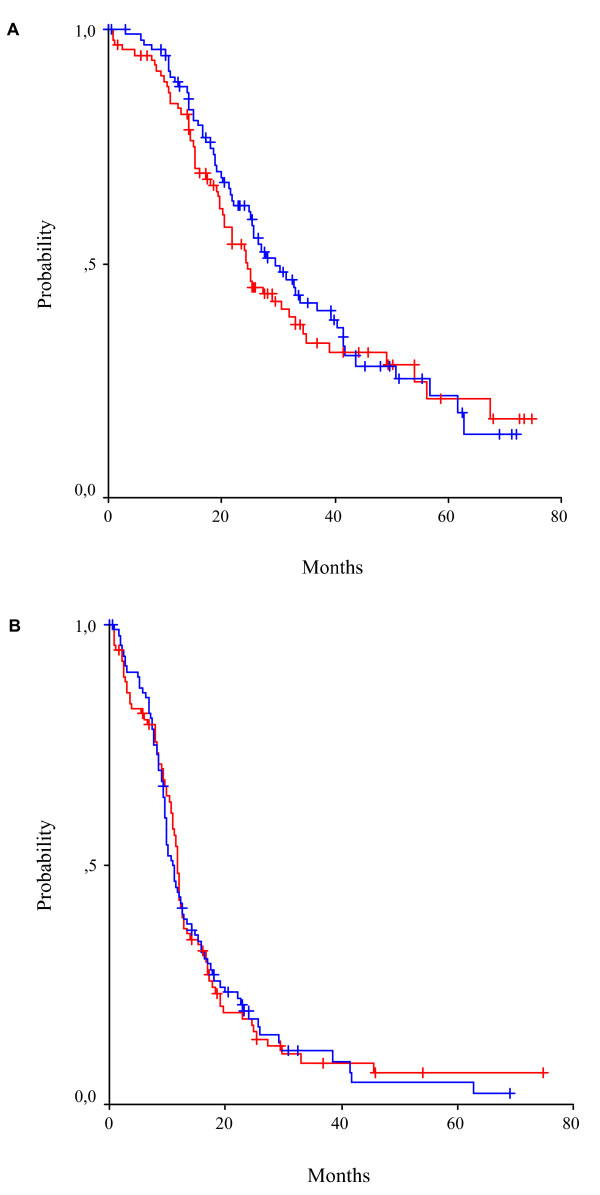
Kaplan-Meier curves for (A) overall survival, (B) time to progression. The blue line corresponds to group A, while the red line to group B.